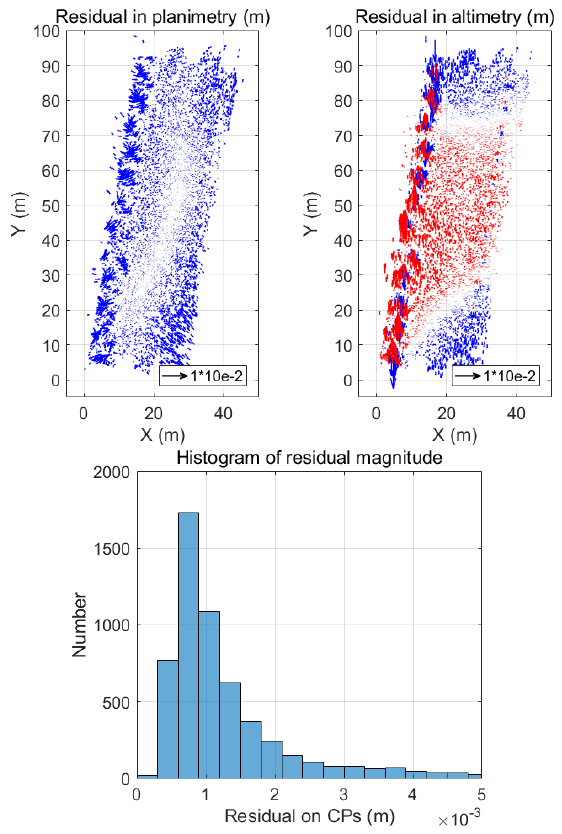
Figure 10. The spatial distribution of the residuals on CPs when a local Gaussian error is added. Upper left : residual on planimetry, vector direction and magnitude represent residual direction and magnitude, respectively. Upper right : residual on altimetry, vector direction and color represent the sign of residuals, upward red means positive, downward blue means negative; vector magnitude represents residual magnitude. The first two images share the same scale. Bottom : histogram of residual magnitude. are obtained whereas the accuracy of 3D measurement is com-